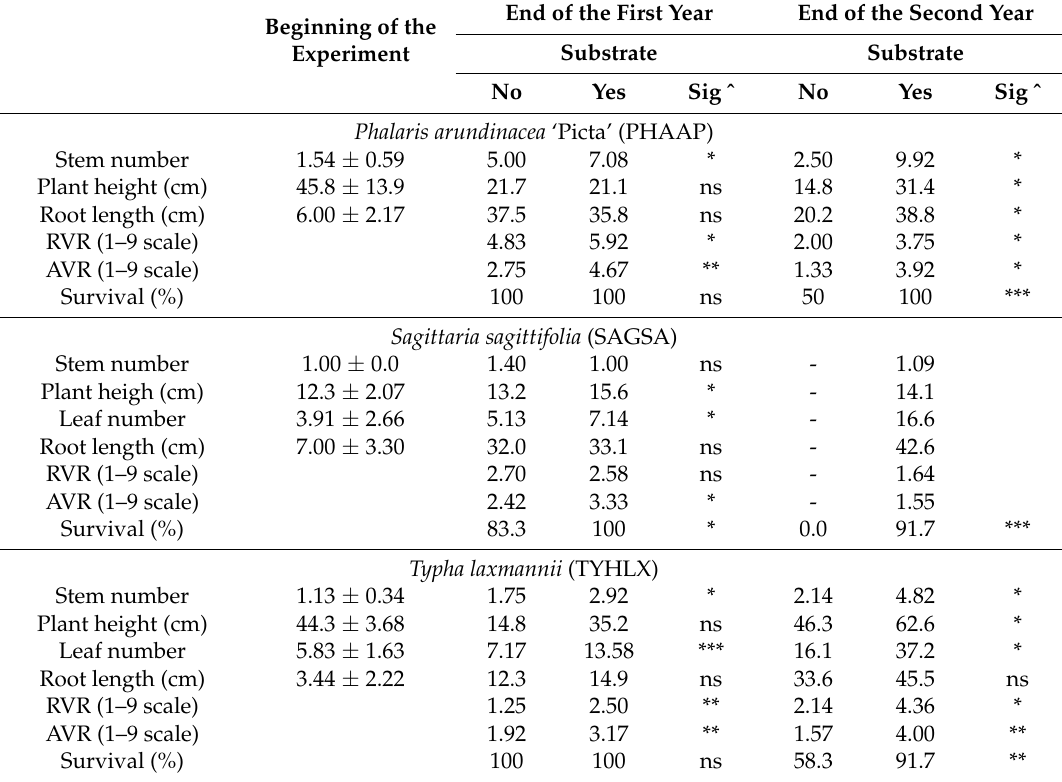
Table 4. Plants characteristics at the beginning of the experiment, at the end of the first year, and at the end of the second year.